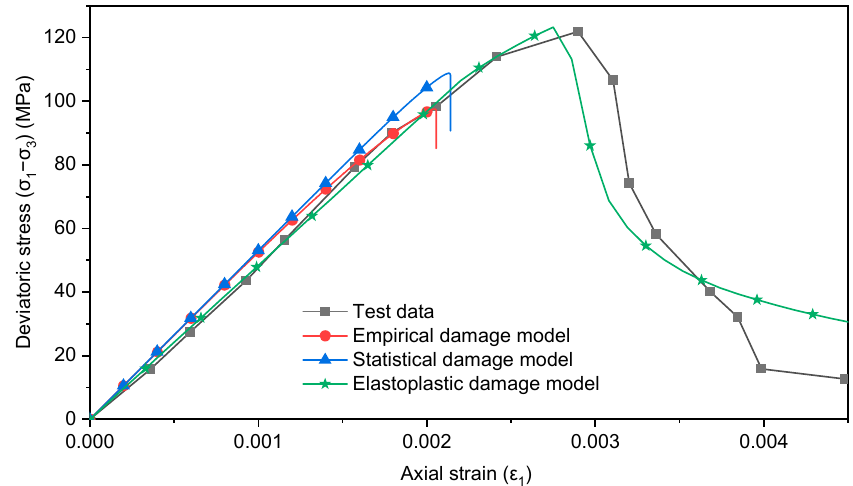
Figure 6. Stress–strain curves under ununiform stress condition.